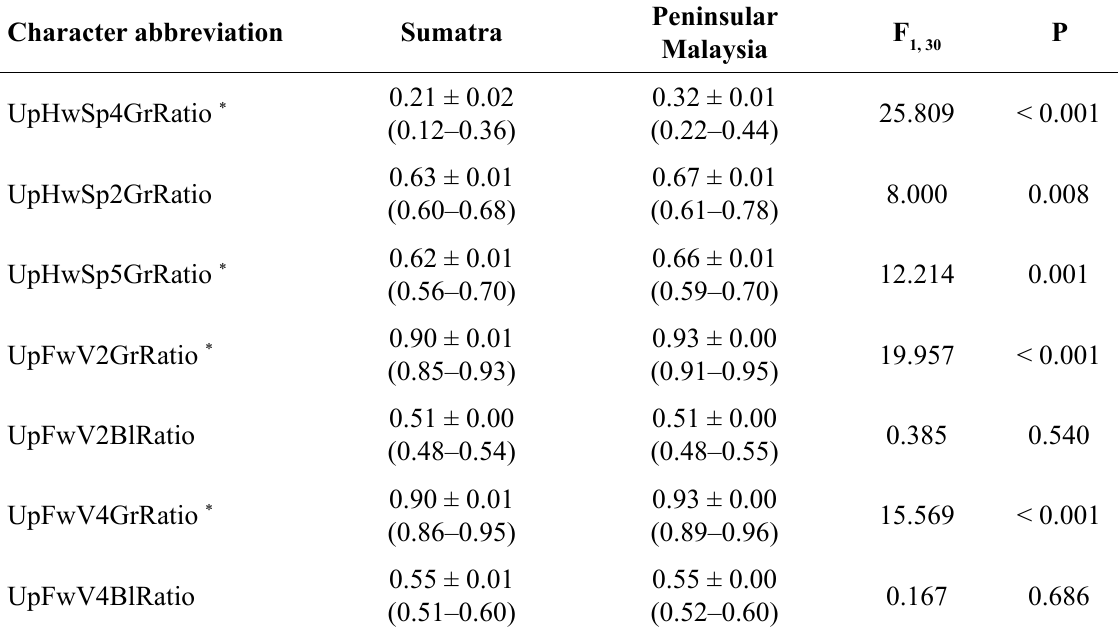
Table 5. ratio characters for Sumatran and Peninsular malaysian males (mean ± standard error, and